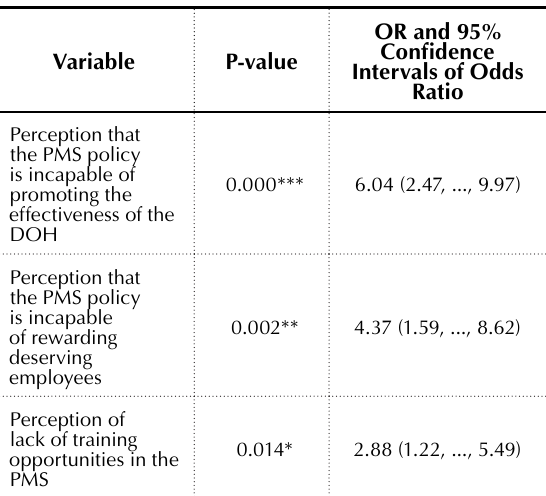
Table 3. Odds Ratios (OR) estimated from binary logistic regression